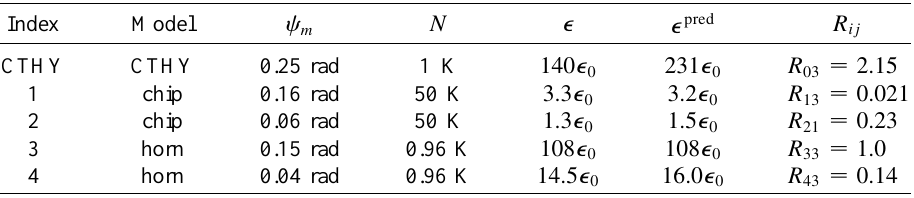
TABLE II. Laser-wakefield accelerator models: 2.5 TeV, s D (cid:1) 0.1 m